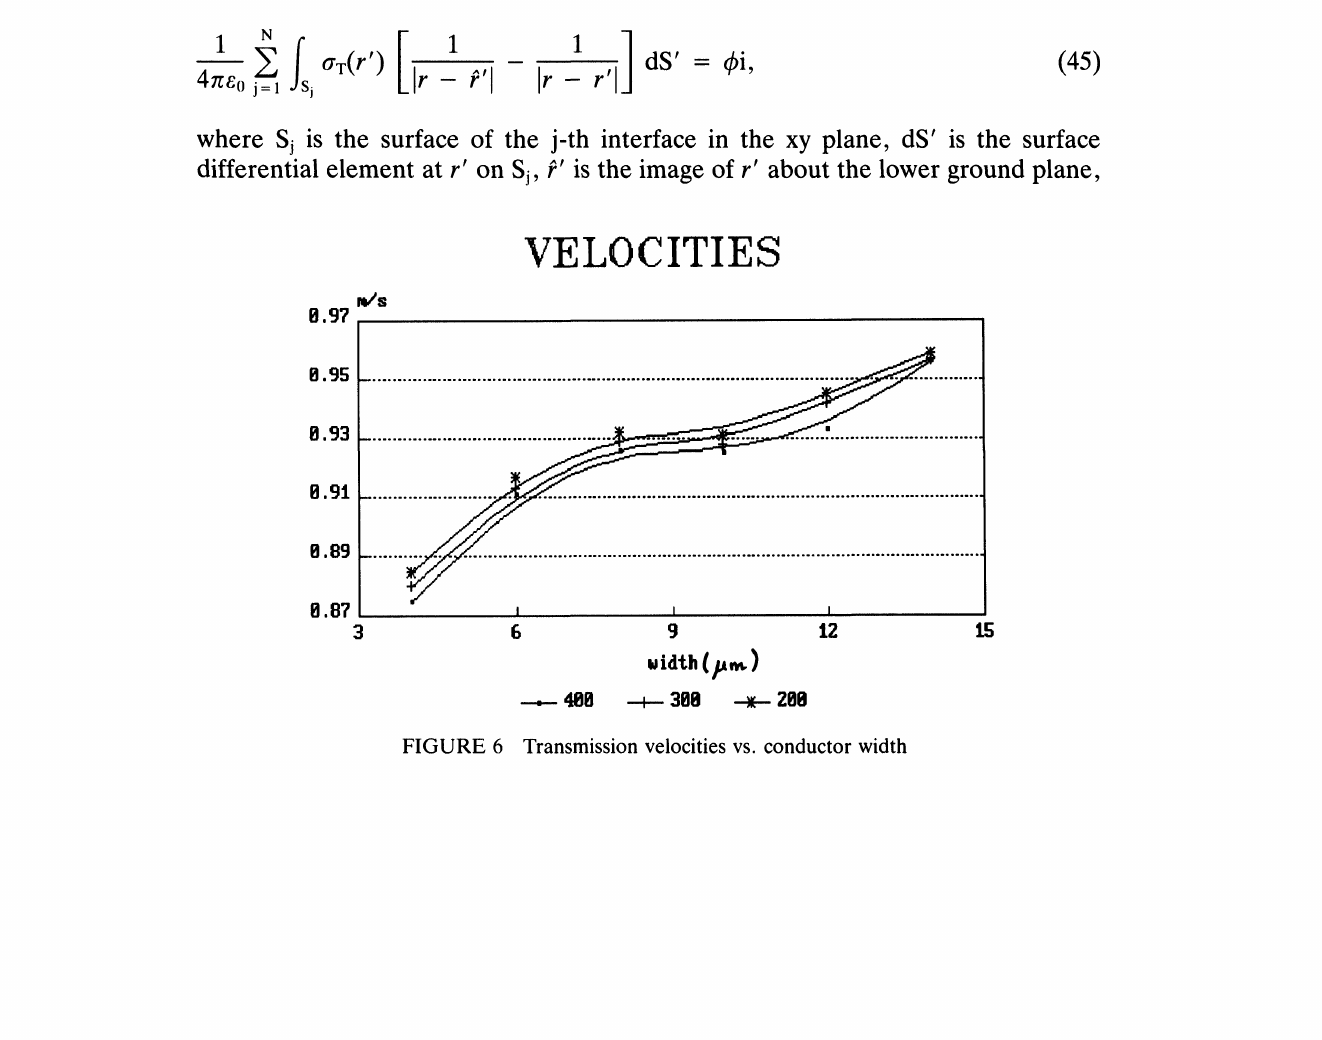
FIGURE 6 Transmission velocities vs. conductor